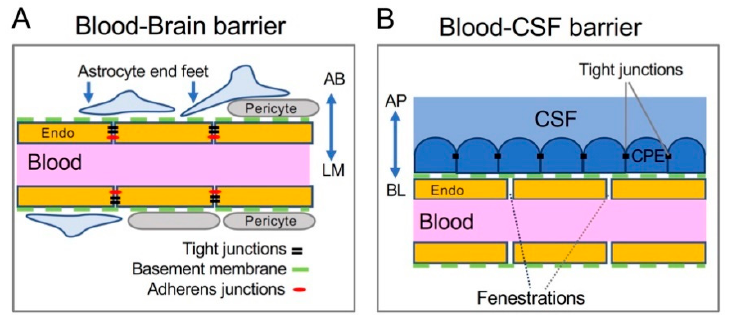
Figure 2. Cellular structures of the brain barriers. ( A ) The BBB is composed of endothelial cells (endo) of the brain blood vessel, and it is supported by pericytes, basement membrane proteins (green dashed line), and astrocytic end feet. The luminal (LM) side of BBB endothelial cells faces the inside of the blood vessel. It is also referred to as the apical side. The abluminal (AB) side faces the brain parenchyma and can exchange between the endothelial cell and the astrocytic end foot or brain extracellular space. It can be considered the basolateral side of BBB endothelium. ( B ) The BCB is made up of choroid plexus epithelial (CPE) cells connected to each other by tight junctions and attached to the blood vessel via basement membrane proteins (green dashed line). The apical (AP), or CSF-facing side of the CPE expresses transporters necessary for the secretion of CSF. On the basolateral (BL), or blood-facing side, CPE cells exchange materials with circulating blood, since endothelial cells in the CP lack tight junctions and permit larger molecules to diffuse.